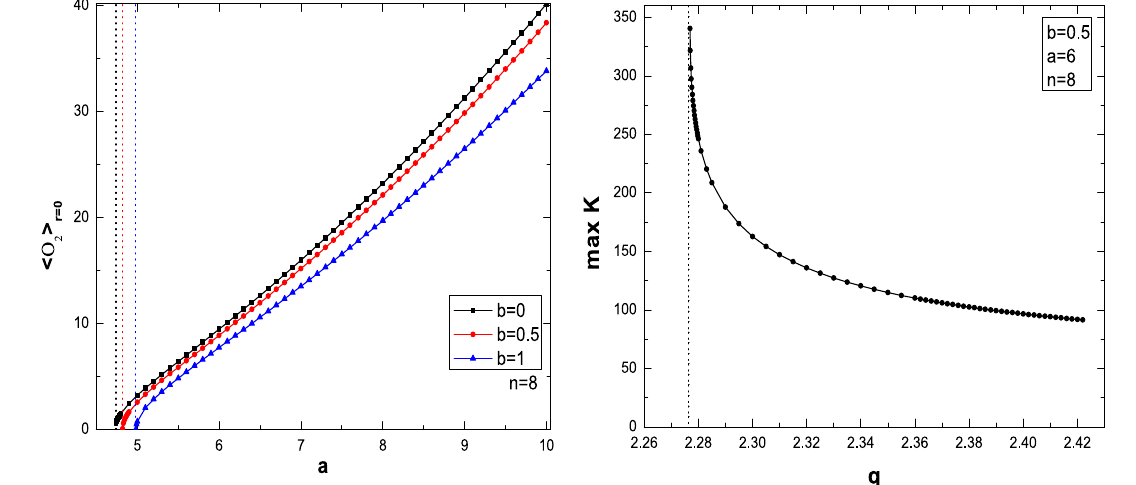
Fig. 4 Left: The condensation against a with different values of b at r = 0. Right: The typical maximal value of Kretschmann scalar K as a function of the charge q with b = 0 . 5, n = 8 and a = 6